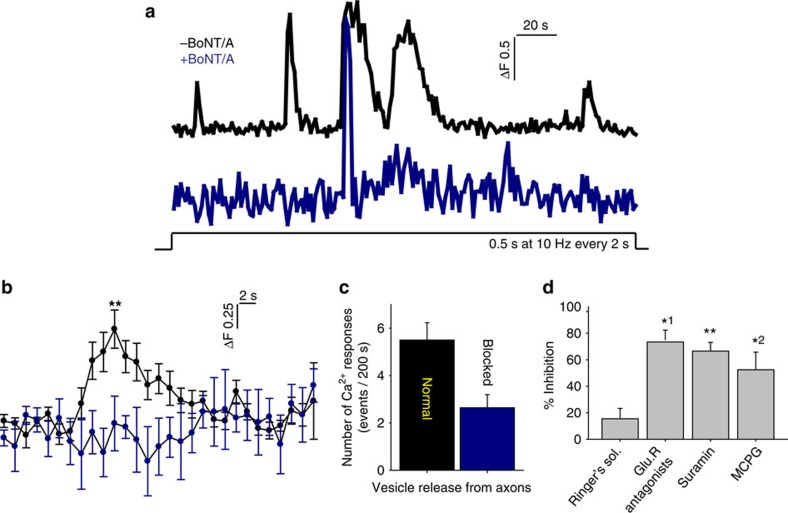
Ca2+ increase in OPC processes is mediated by glutamate and ATP released in response to action potentials in axons.(a) Representative Ca2+ traces in OPC processes in response to electrical stimulation of axons without (black) and with (blue) BoNT/A treatment to block SNARE-dependent exocytosis. (b) Averaged Ca2+ traces in OPCs from 14 dishes are shown. Responses were inhibited by BoNT/A treatment. **P=0.001, t-test, peak amplitude, n=14 cells from 14 dishes with no BoNT/A, n=14 cells from 14 dishes with BoNT/A. (c) Number of Ca2+ responses were reduced significantly by BoNT/A treatment (blocked). The peak Ca2+ response within 200 s of axonal stimulation (10 Hz) were measured. P=0.004, t-test, n=14 cells from 14 dishes with no BoNT/A, n=14 cells from 14 dishes with BoNT/A. (d) Summary graph shows per cent inhibition of Ca2+ responses following treatment with selective blockers of glutamatergic and purinergic neurotransmitter receptors, including a combination of CNQX, DAPV, MCPG (GluR antagonists), suramin and MCPG. The results implicate both glutamate and ATP neurotransmitter signalling. P=0.3, n=6 cells from six dishes, *1P=0.03, n=4 cells from four dishes, **P=0.008, n=5 cells from five dishes, *2P=0.02, n=6 cells from six dishes, all paired t-test.